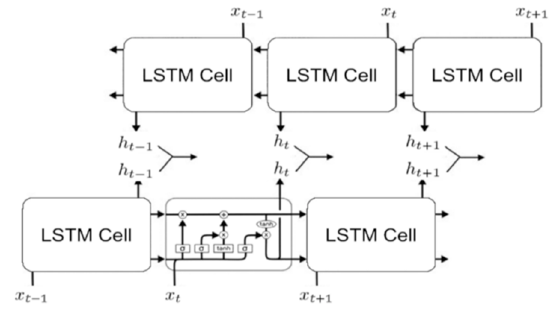
Figure 3. The architecture of BiLSTM Cell.